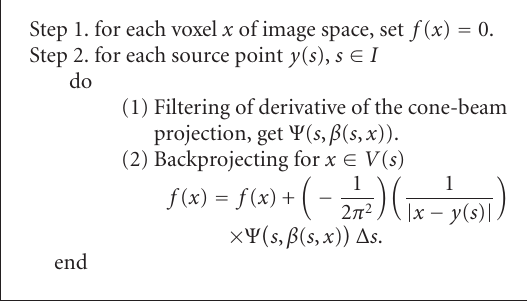
method provides an approach to performing backprojection.